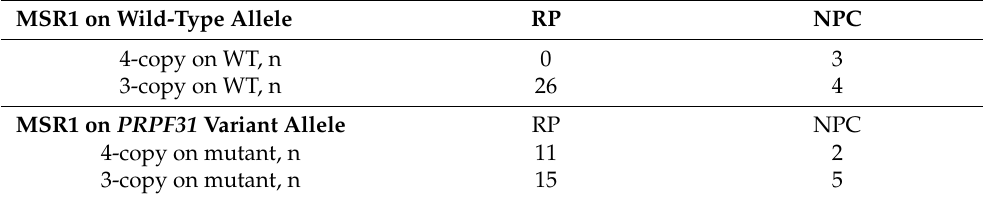
Table 2. MSR1 CNV on the wild-type allele and the mutant allele in individuals with a PRPF31 -variant. MSR1 on Wild-Type Allele RP NPC 4-copy on WT, n 0 3 3-copy on WT, n 26 4 MSR1 on PRPF31 Variant Allele RP NPC 4-copy on mutant, n 11 2 3-copy on mutant, n 15